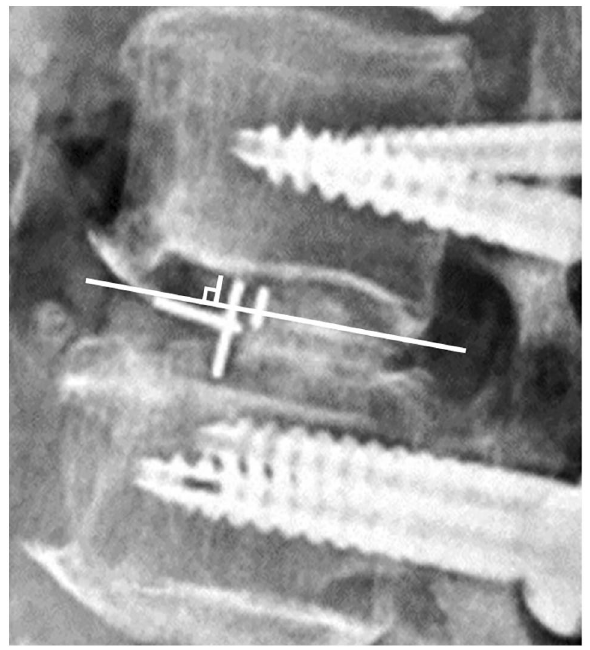
Figure 3. Cage subsidence was defined as a cage migrating more than 2 mm into the superior or inferior endplate of adjacent vertebrae.